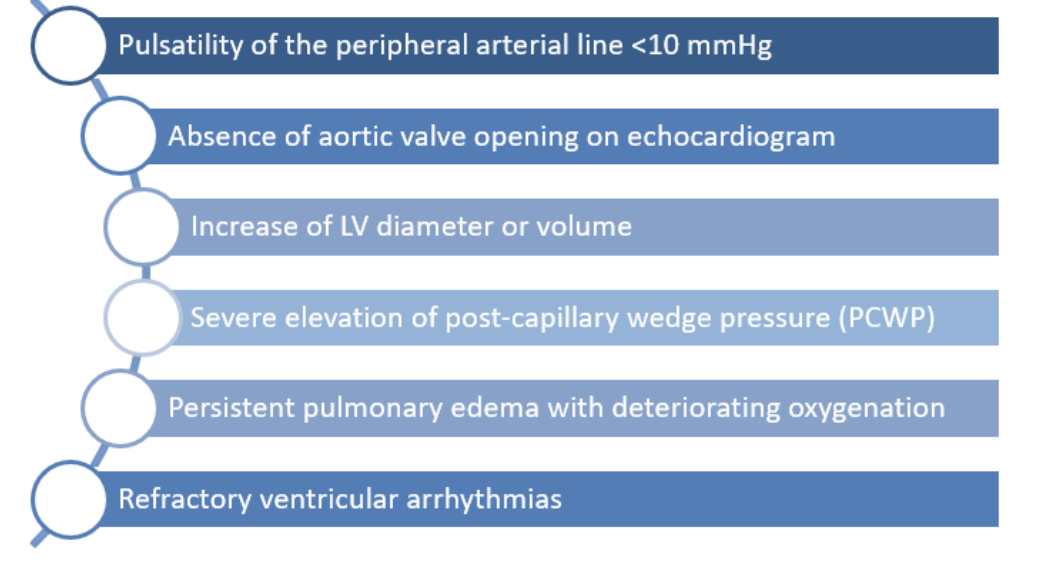
Figure 2. Potential indications for LV venting during VA-ECMO therapy. LV = left